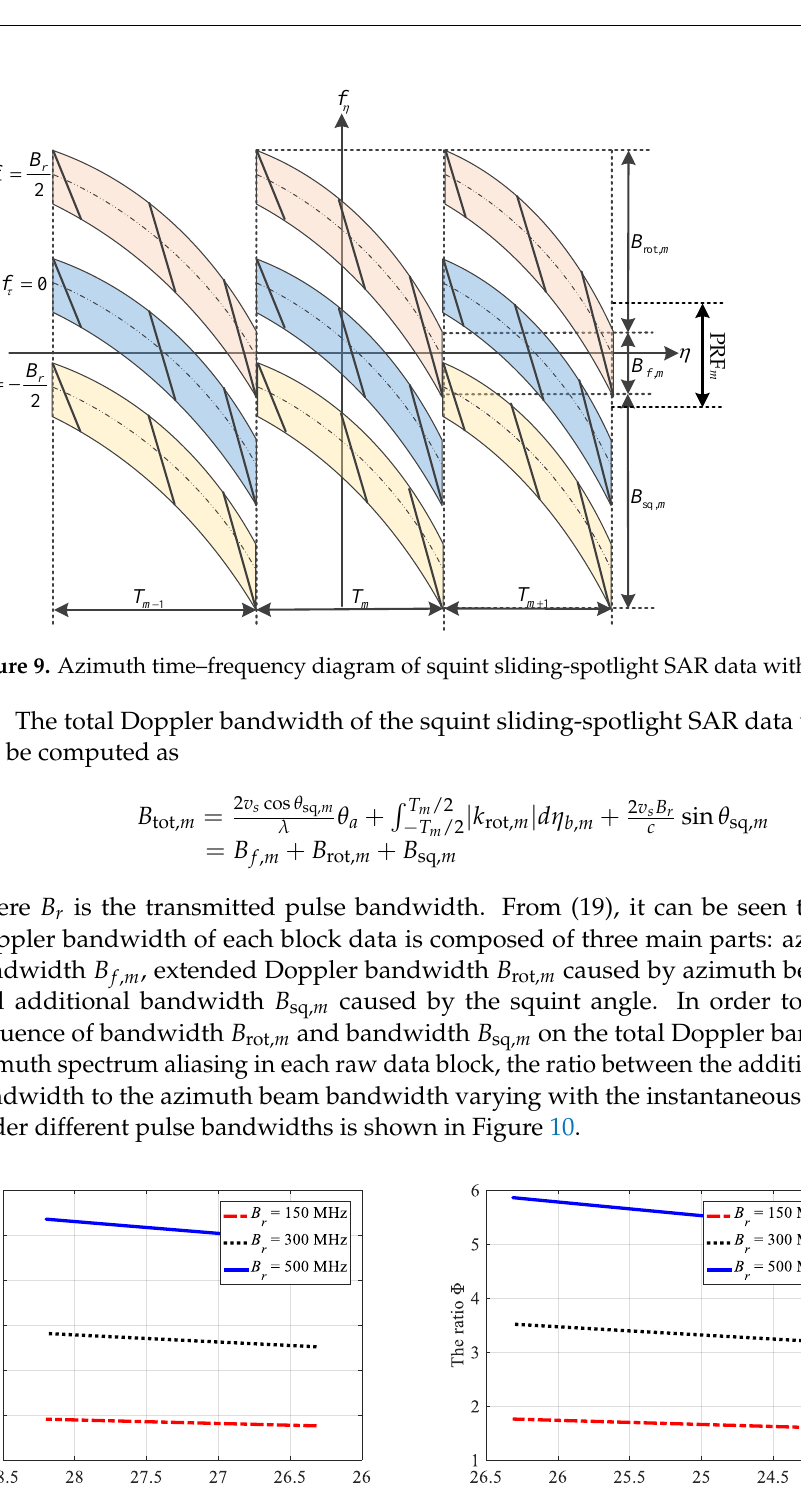
where is the carrier frequency, and